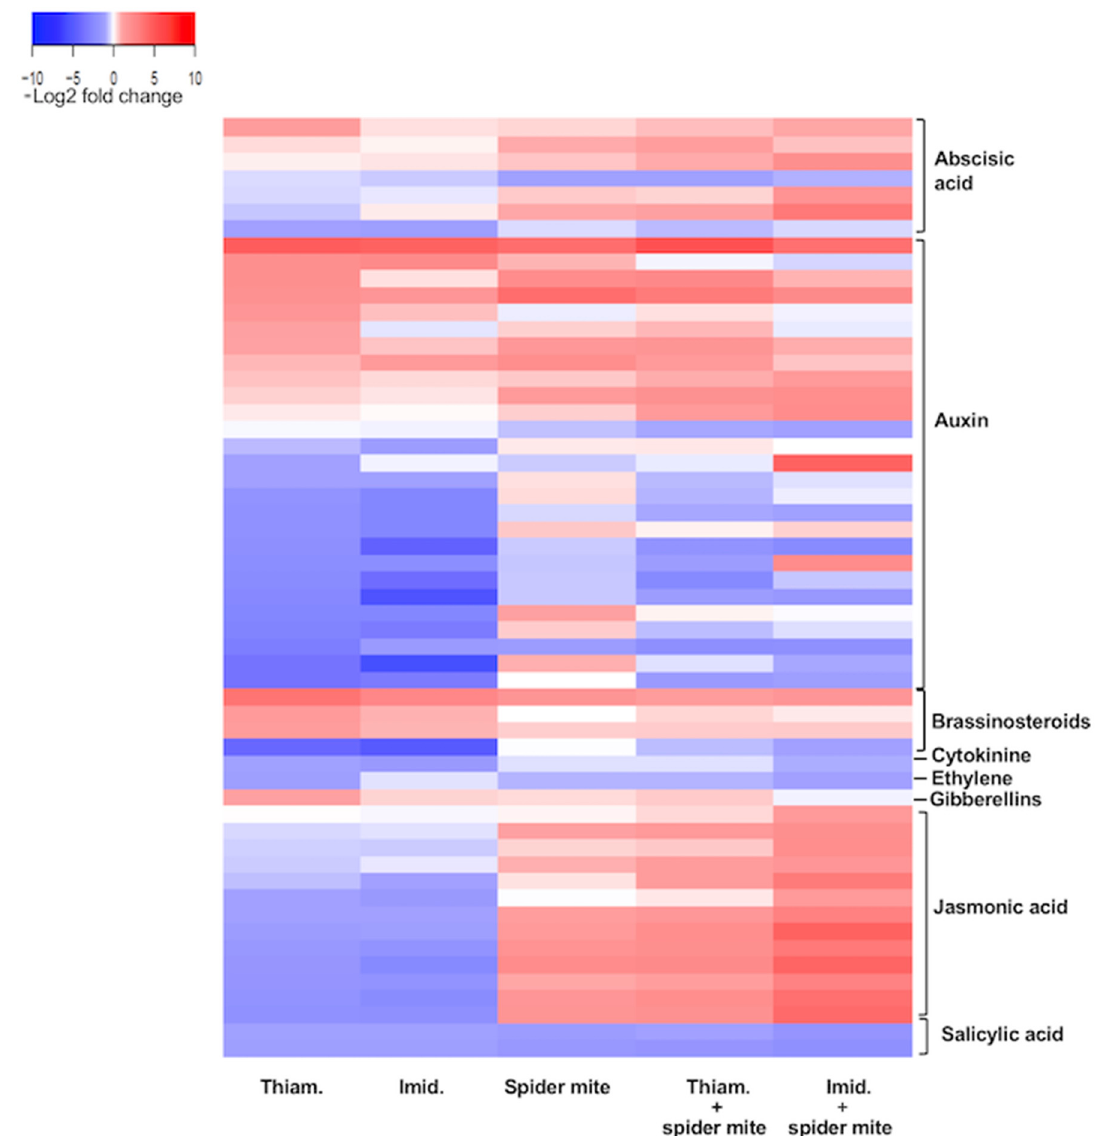
Figure 4. Heat map of DEGs associated with plant hormone transduction pathways in soybean plants exposed to thiamethoxam, imidacloprid, spider mite, and the combination of either neonicotinoid and spider mites. The color key represents log2-transformed fold change; red bars indicate induction of expression, while blue bars represent a decrease in expression.